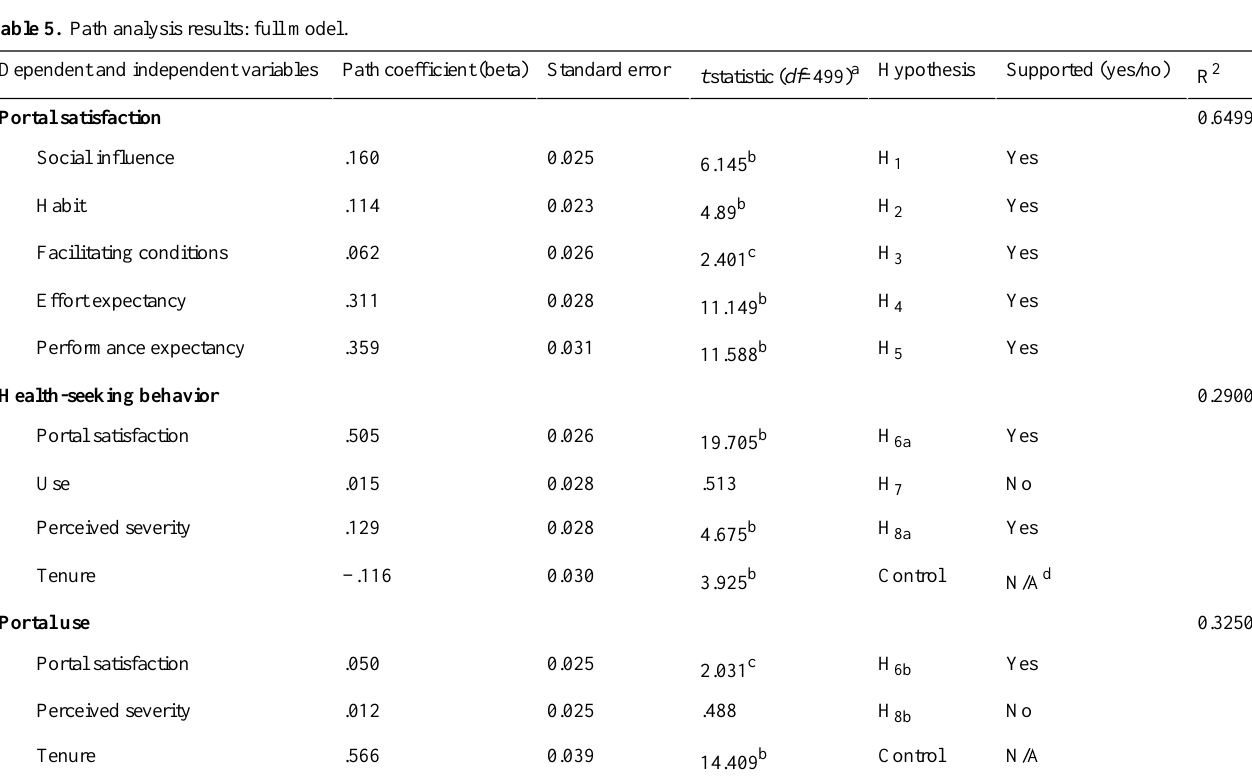
Table 5. Path analysis results: full